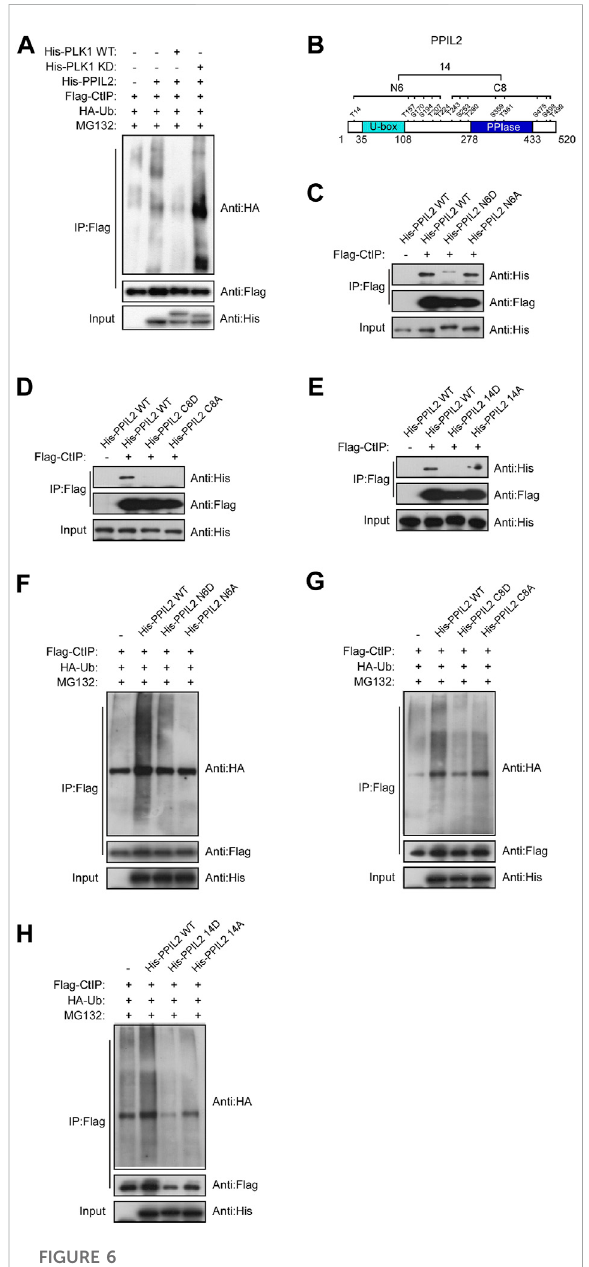
FIGURE 6 Phosphorylation of PPIL2 by PLK1 suppresses CtIP ubiquitination. (A) 293T cells were cotransfected with Flag-CtIP, His-PPIL2,HA-Ub,andHis-PLK1WTorkinasedead(KD).48 hpost transfection, the cells were treated with MG132 (20 μ M) for 3 h.ThecellswerethenlysedinNETNbuffercontainingaprotease inhibitorcocktail(PIC),andthecelllysatewasimmunoprecipitated with anti-Flag and analysed by immunoblotting with anti-HA. (B) Schematic diagram of the potential PLK1 phosphorylation target siteonPPIL2. (C,D,E) 293Tcellswerecotransfected withFlag-CtIP and His-PPIL2 mutant expression constructs and then assayed